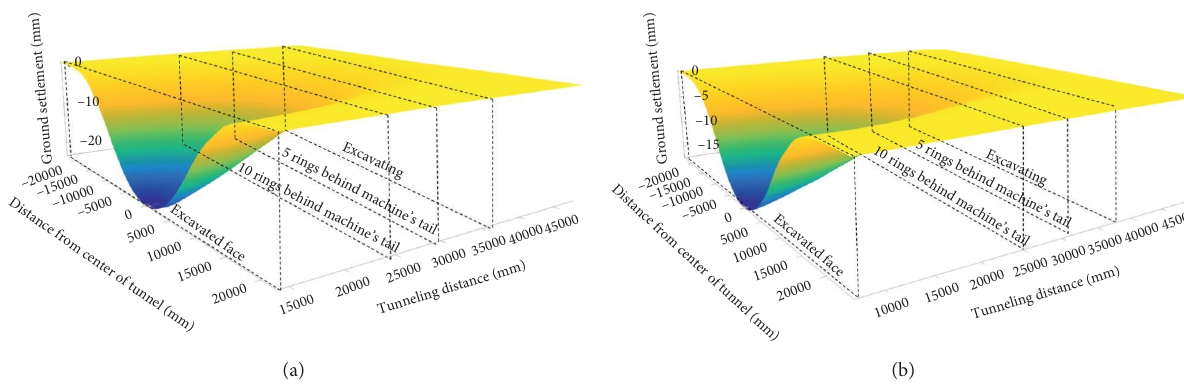
Figure 9: 3D surface settlement during excavation by shield and pipe jacking in numerical simulation: (a) 3D surface settlement during shield excavation. (b) 3D surface settlement during pipe jacking excavation.